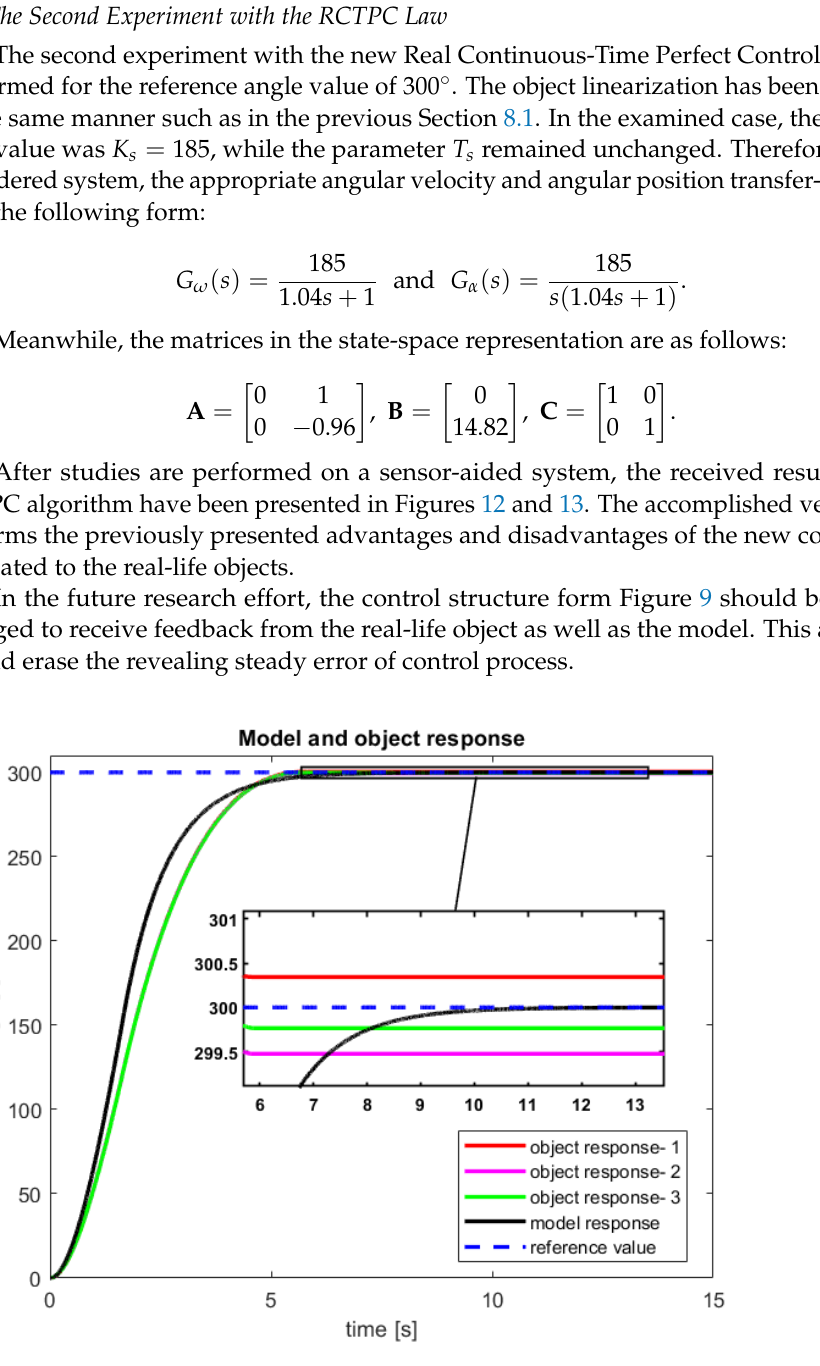
Figure 12. The received angular position of the model and the sensor-aided object—results of the three attempts with 300 ◦ reference value (source: